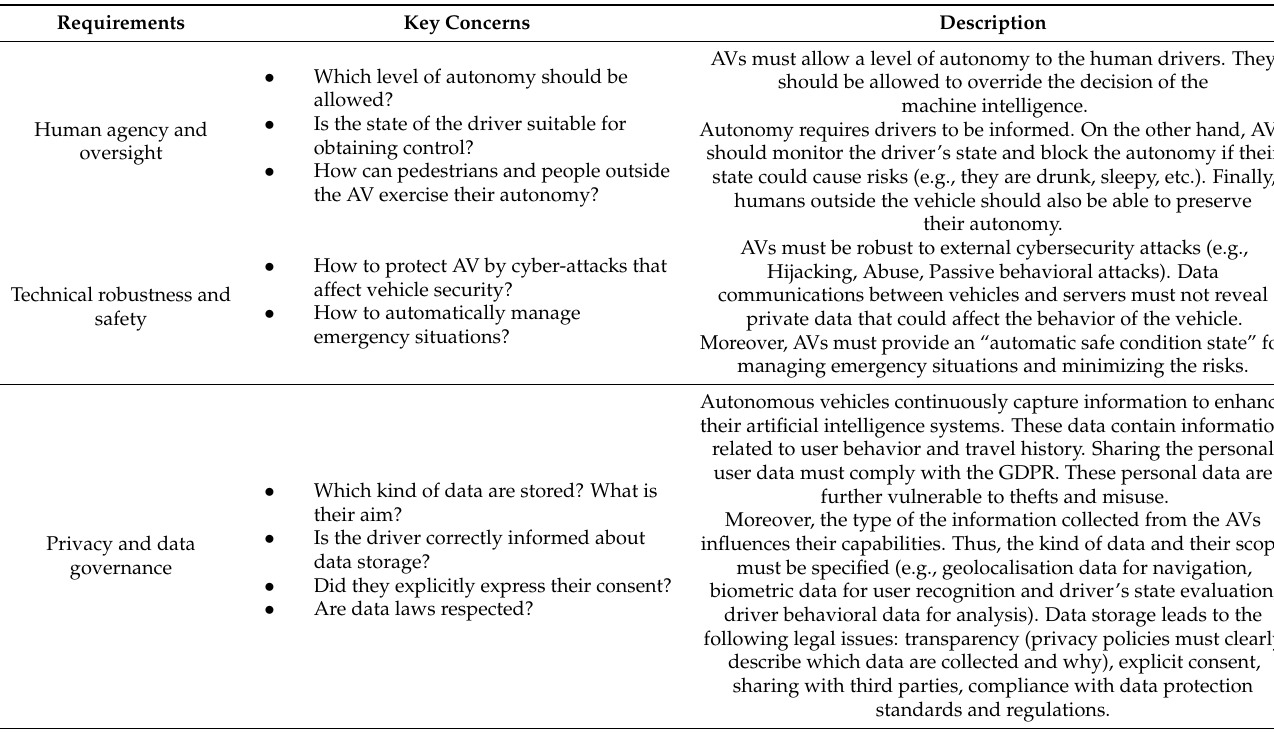
Table 6. Requirements for autonomous vehicles based on fundamental